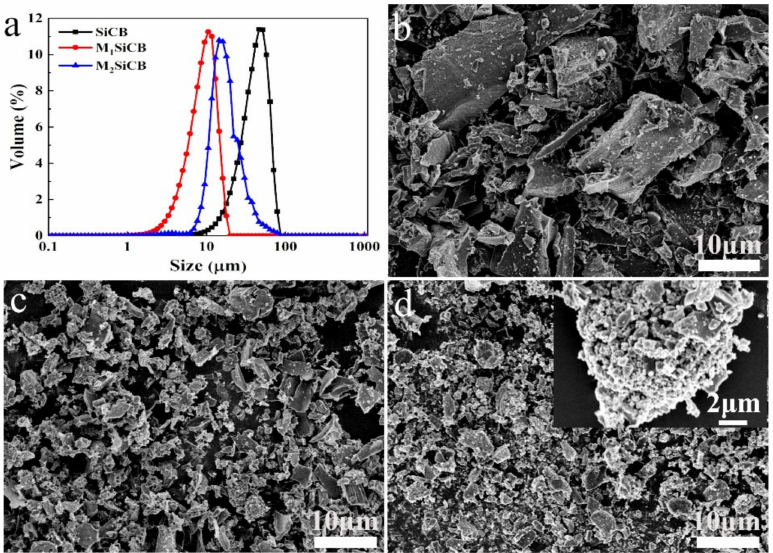
Figure 1. ( a ) The particle size distribution of fillers, SEM of ( b ) SiCB, ( c ) M 1 SiCB and ( d ) M 2 SiCB. The morphologies of the obtained fillers were observed by SEM. SiCB showed large irregular shape with bright particles distributed over the surface of the primary